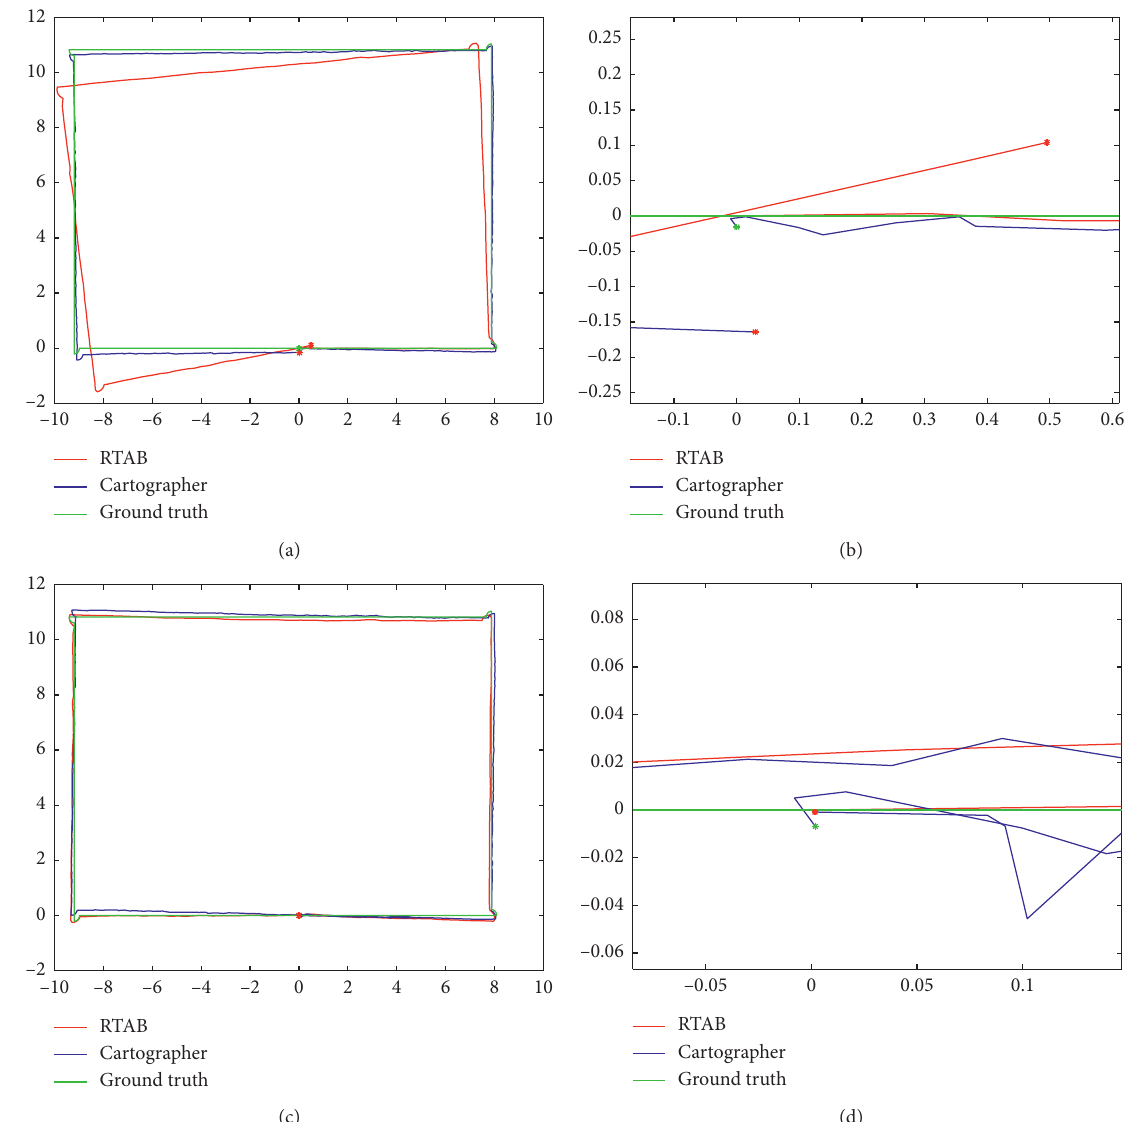
Figure 14: Trajectory accuracy contrast. (a) Accuracy comparison of the odometer. (b) Comparison of odometer accuracy after robot returns to origin. (c) Accuracy comparison of loop-closure. (d) Comparison of loop-closure accuracy after robot returns to origin. Unit: